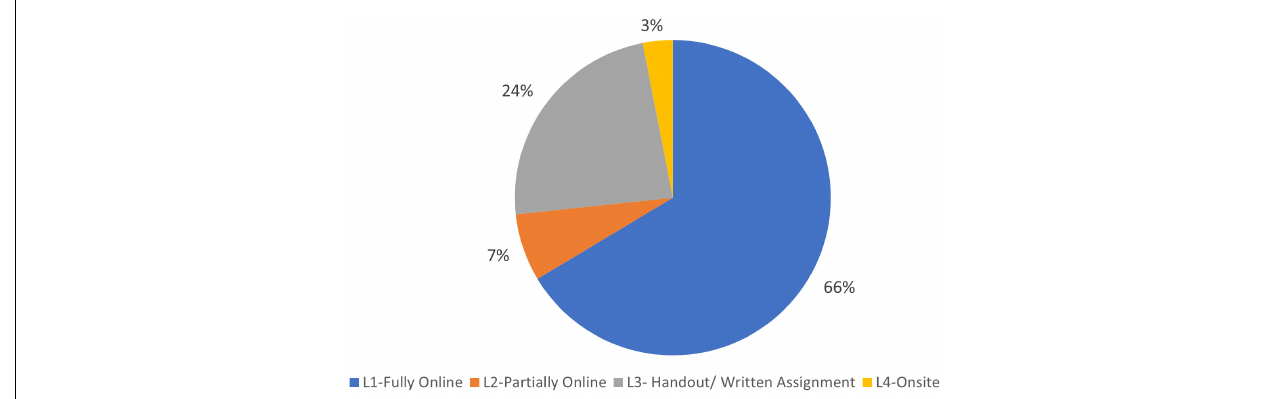
FIGURE 1 | Percentage of Thai students by learning method during the COVID-19